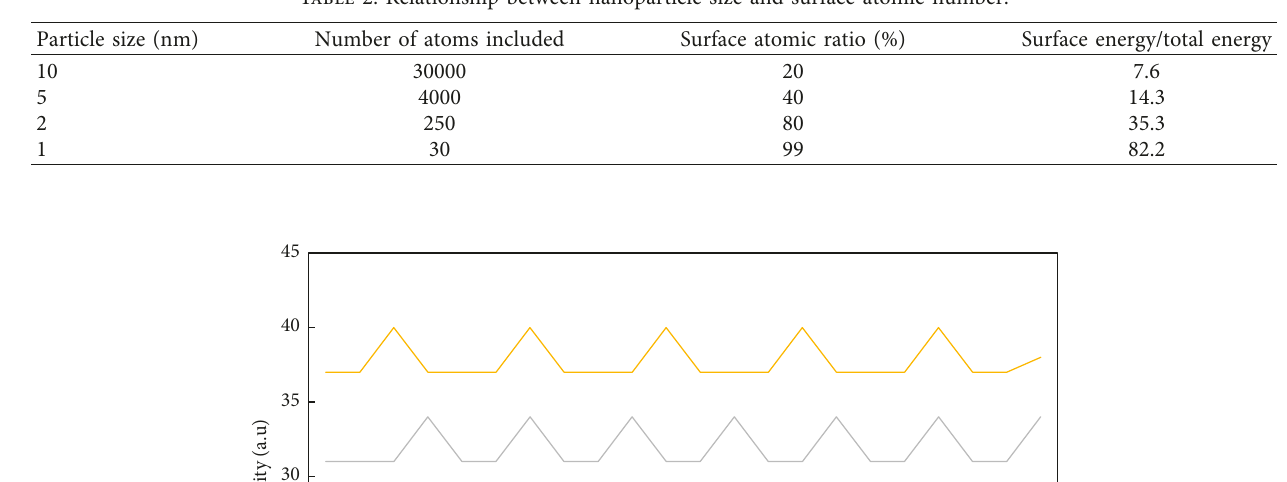
3 nanofiber precursor solution.